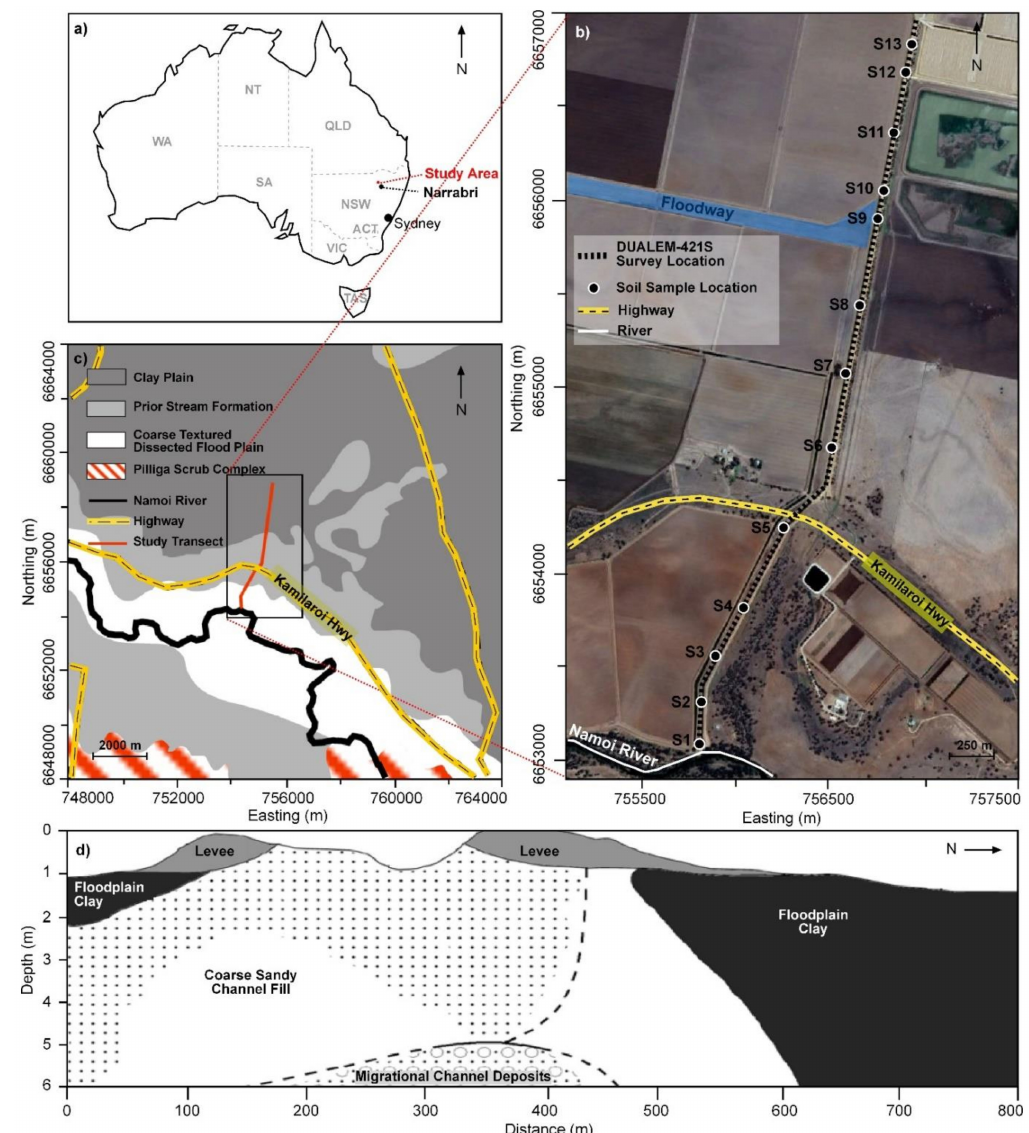
Figure 1. ( a ) Location of the study area, ( b ) air photo (Google Earth) of the study supply channel either side of the Kamilaroi Highway and a local floodway with a location of soil apparent electrical conductivity (EC a —mS m − 1 ) survey transect and soil sample sites (13), ( c ) physiography of the lower Namoi valley (after Stannard and Kelly, 1968 [14]) and ( d ) general shallow stratigraphy near prior stream channels nearby Gwydir Valley (after Pietsch, 2006